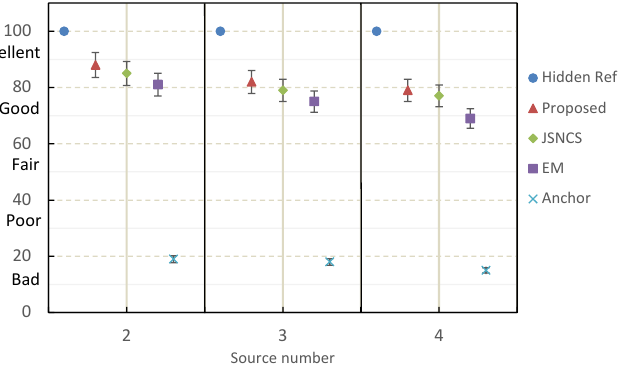
Figure 13. MUSHRA test results under the ideal acoustic case with 95% confidence intervals.